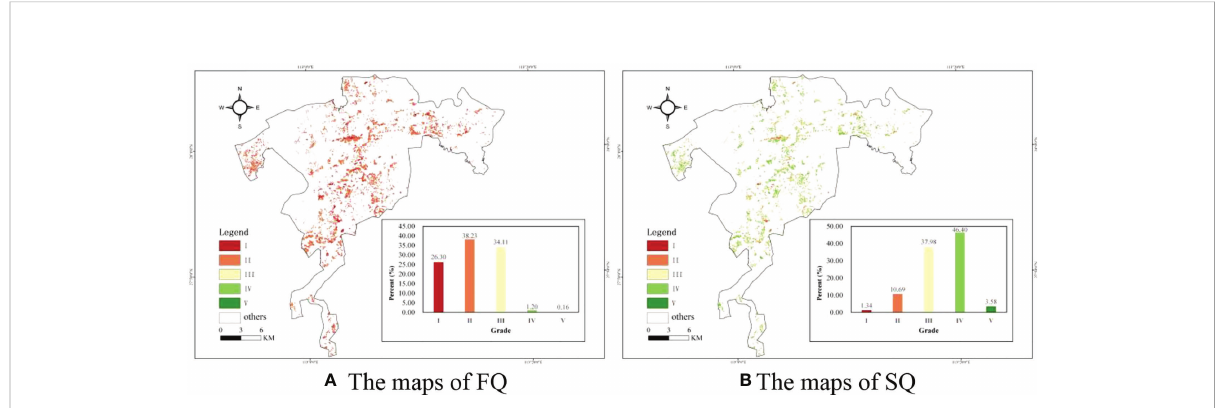
FIGURE 6 The Maps of the graded FQ and SQ and the histograms of fi ve grades. (A) The maps of FQ (B) The maps of